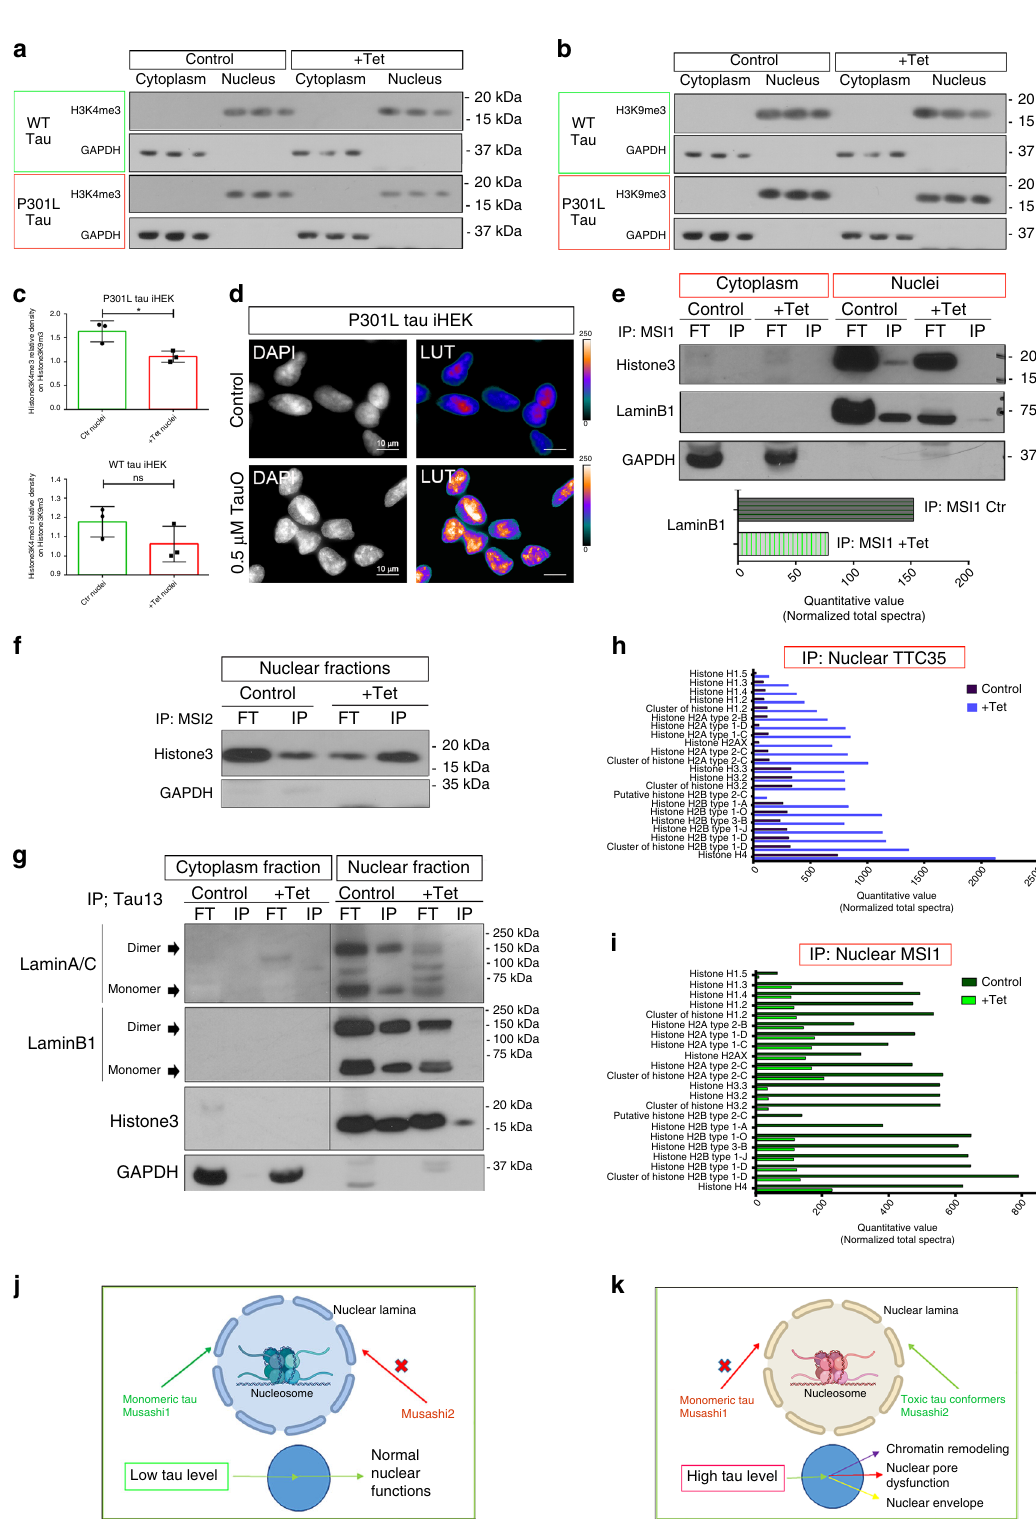
Tau increment in + Tet cells has been con fi rmed by MS (Supplementary Fig. 9d). MSI and tau bind Histone3 modulating chromatin state in the cells . We evaluated markers of chromatin condensation by Western blot to establish if high levels of WT and P301L tau